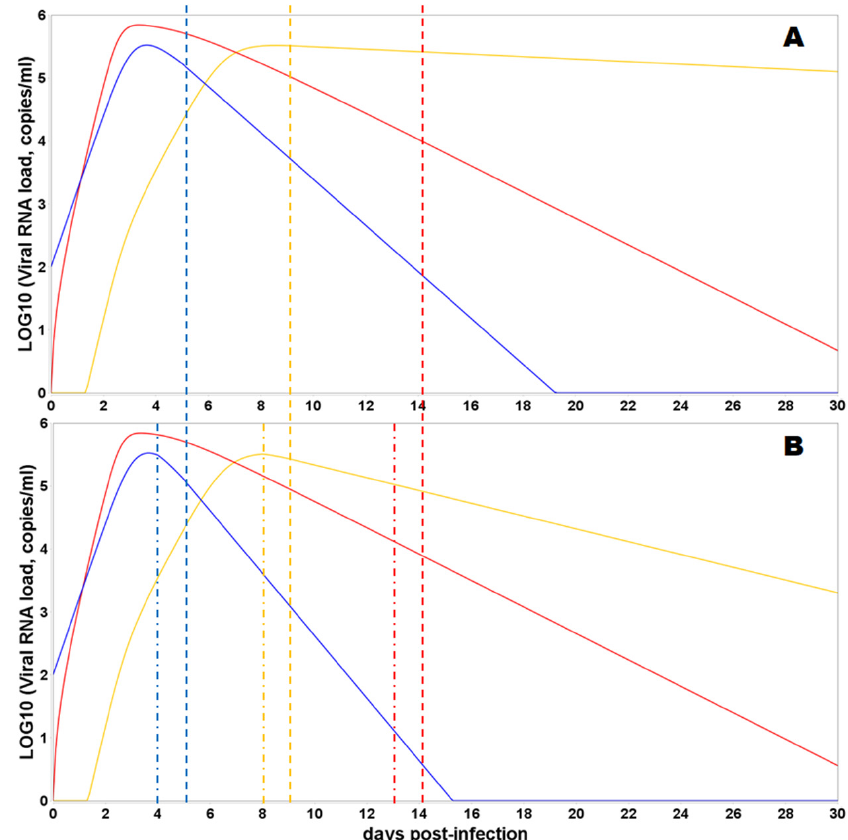
Figure 6. Predicted viral load trajectories in the nasopharyngeal region (NP, blue curve), gastroin- testinal tract (intestine, red curve), and lungs (lung, orange curve), depending on the consideration of the T-cellular response, are shown. The dashed vertical lines correspond to the timing of humoral immune response initiation in a certain compartment, while dash-dotted lines represent the initiation of T-cellular immune response in a certain compartment (the color of the dashed and dash-dotted lines correspond to the color of the viral trajectory in the compartment). The initial viral load is 100 viral particles in the NP. Y -axis—log10 of viral load (copies/mL); X -axis—days from the moment of infection. ( A ) Only B-cellular response is involved in the virus clearance. ( B ) B- and T-cellular responses are activated.